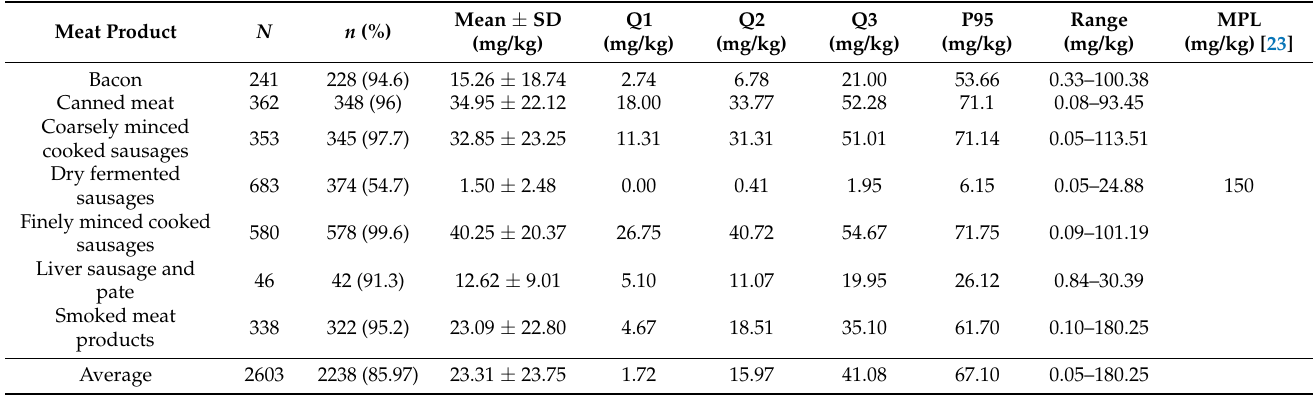
Table 3. Mean levels and ranges of nitrite content expressed as NaNO 2 in examined processed meat products